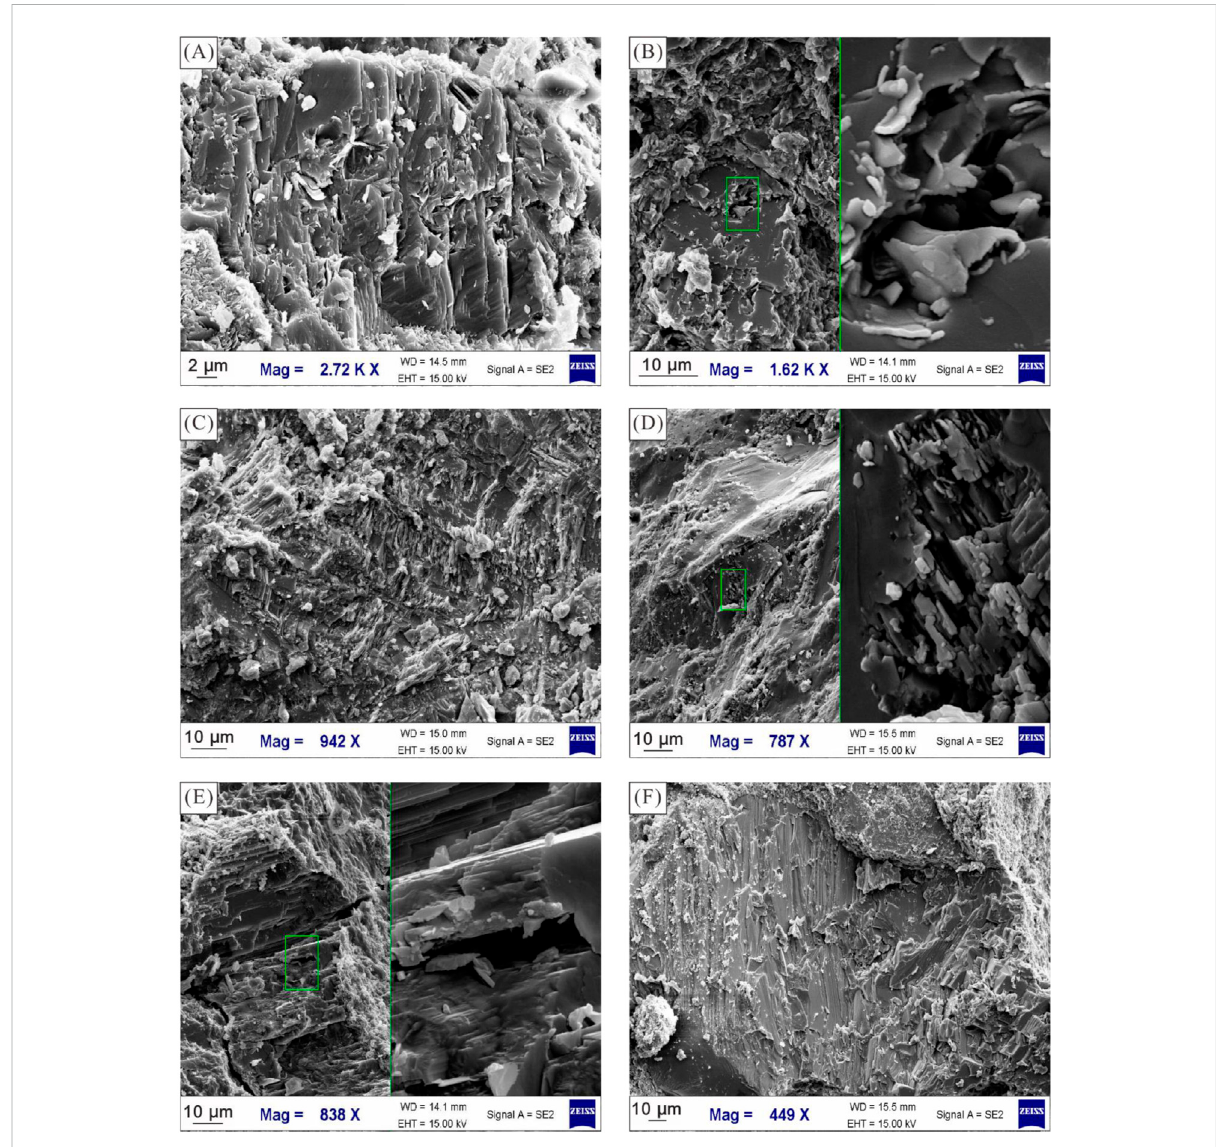
FIGURE 15 Dissolution characteristics of P 3 w reservoir in the Fukang Sag (A) Well Fu47, 5128.80 m, P 3 w, and grain surface dissolution of feldspar; (B) Well Fu48, 4542.36 m,